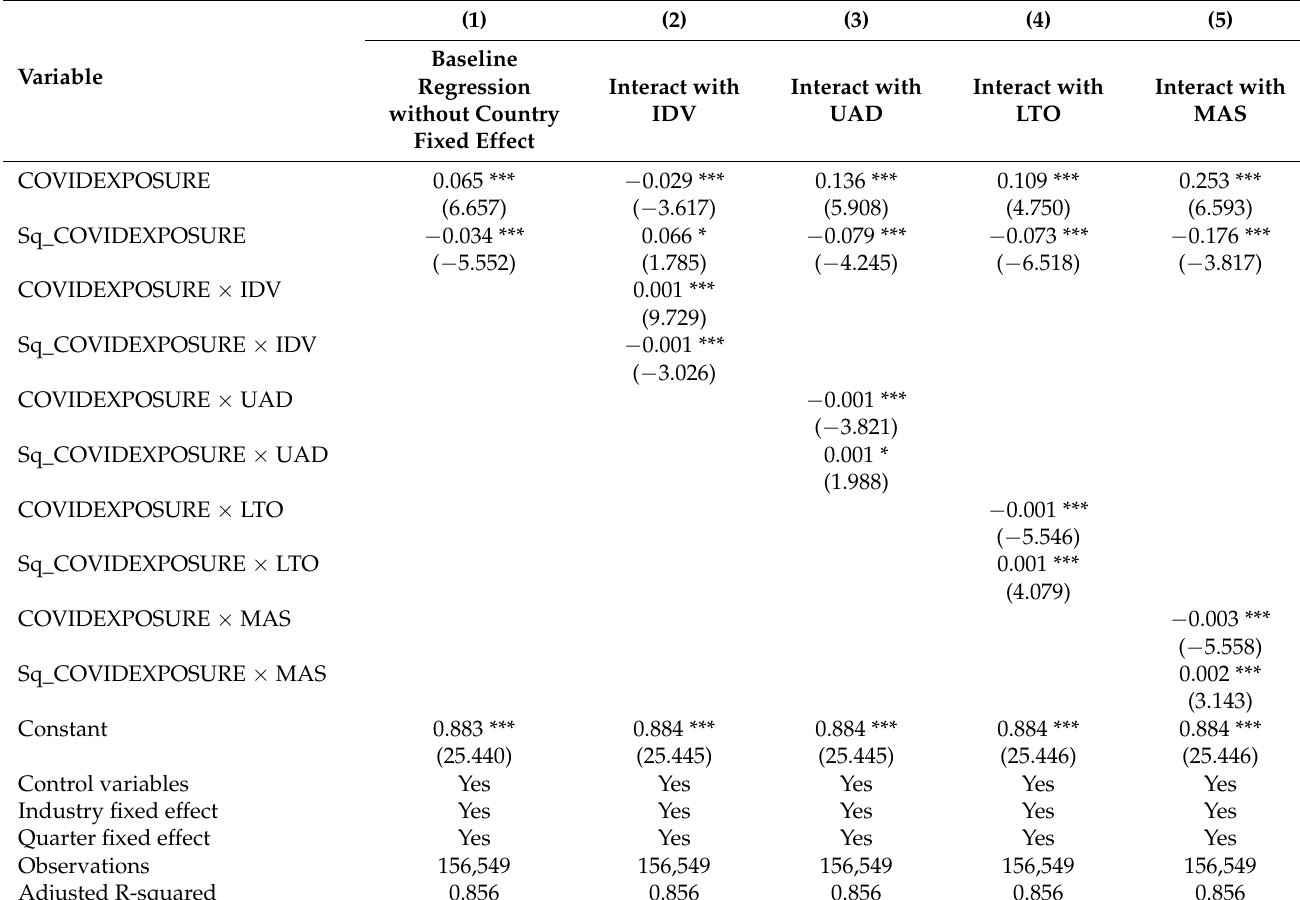
Table 6. The role of national culture